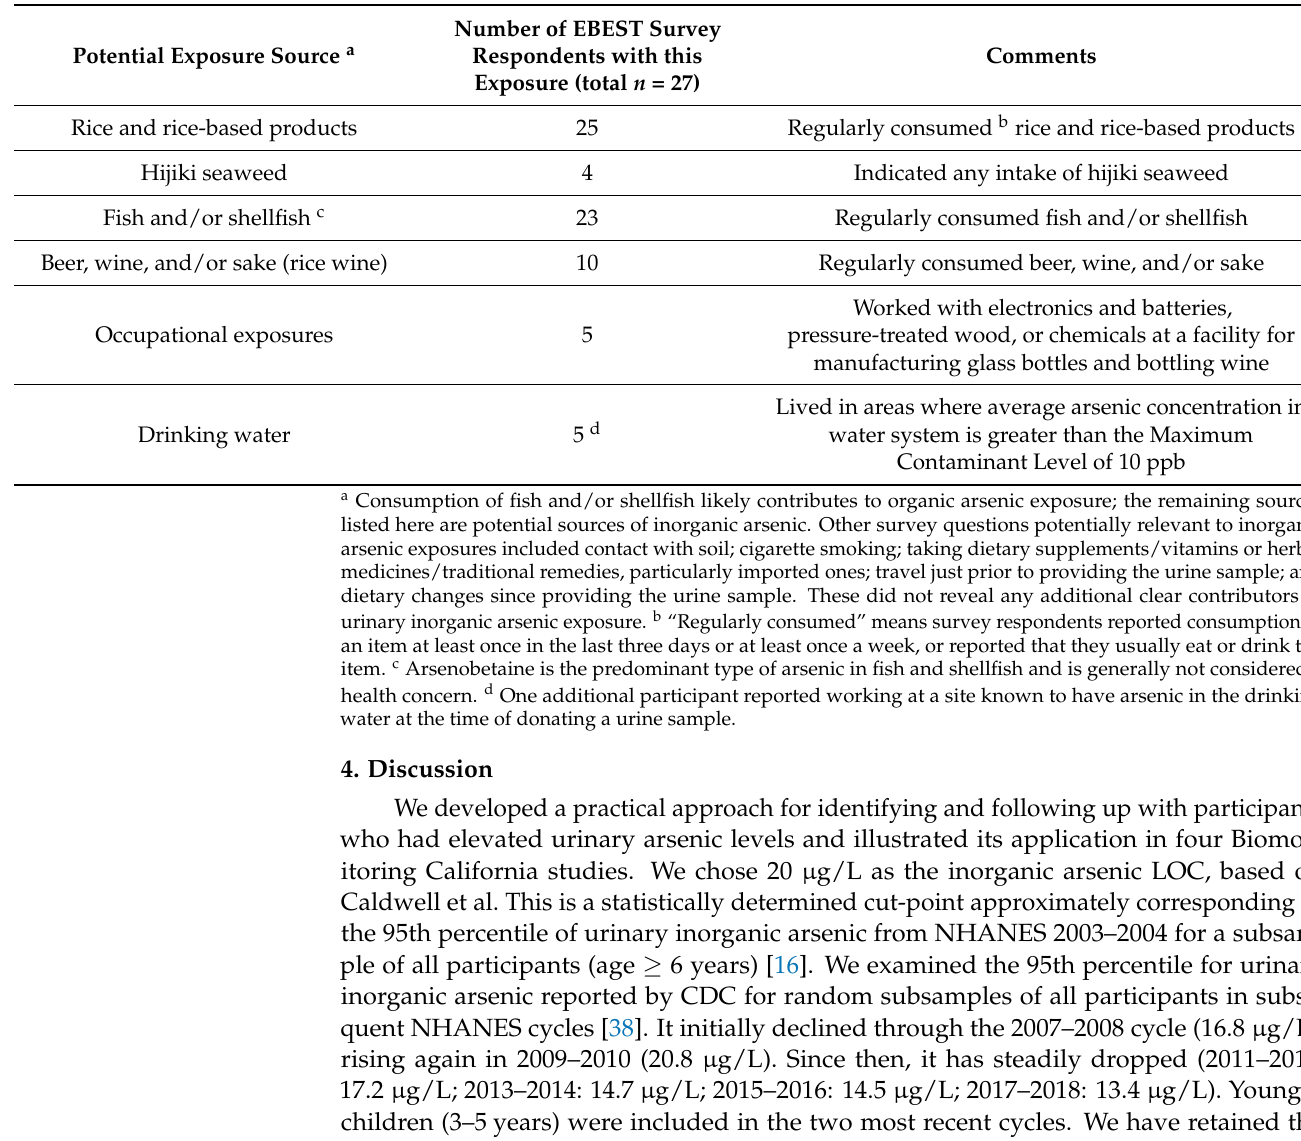
Table 2. Potential sources of arsenic exposures for EBEST telephone survey